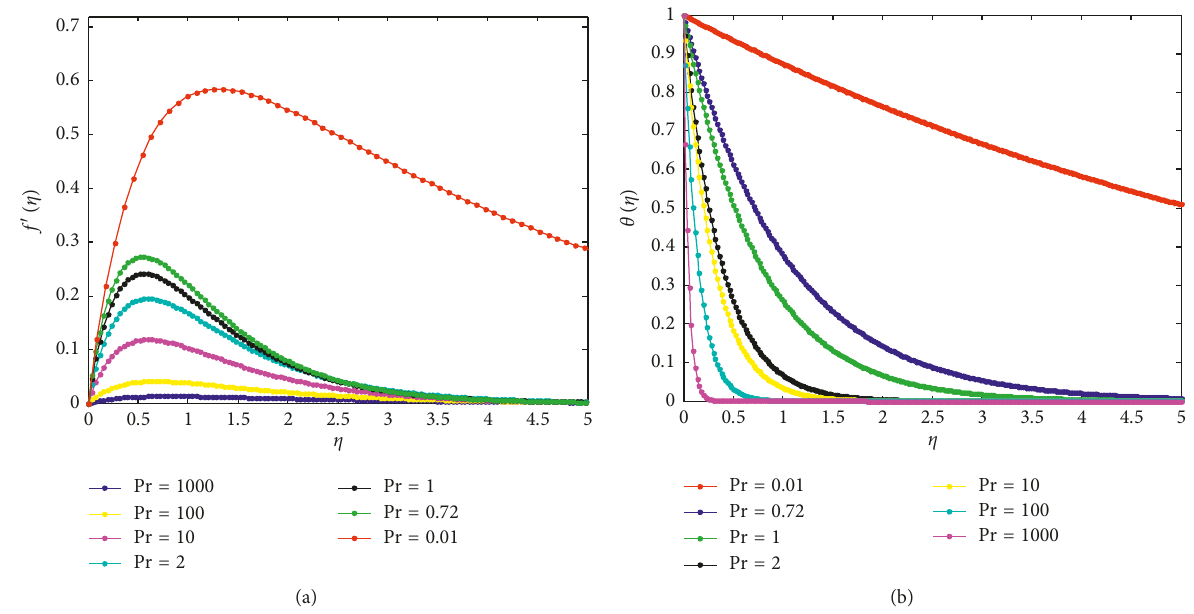
Figure 15: (a) Effects of Prandtl number on the velocity profile for lamina-shaped nanoparticle. (b) Effects of Prandtl number on the temperature profile for lamina-shaped